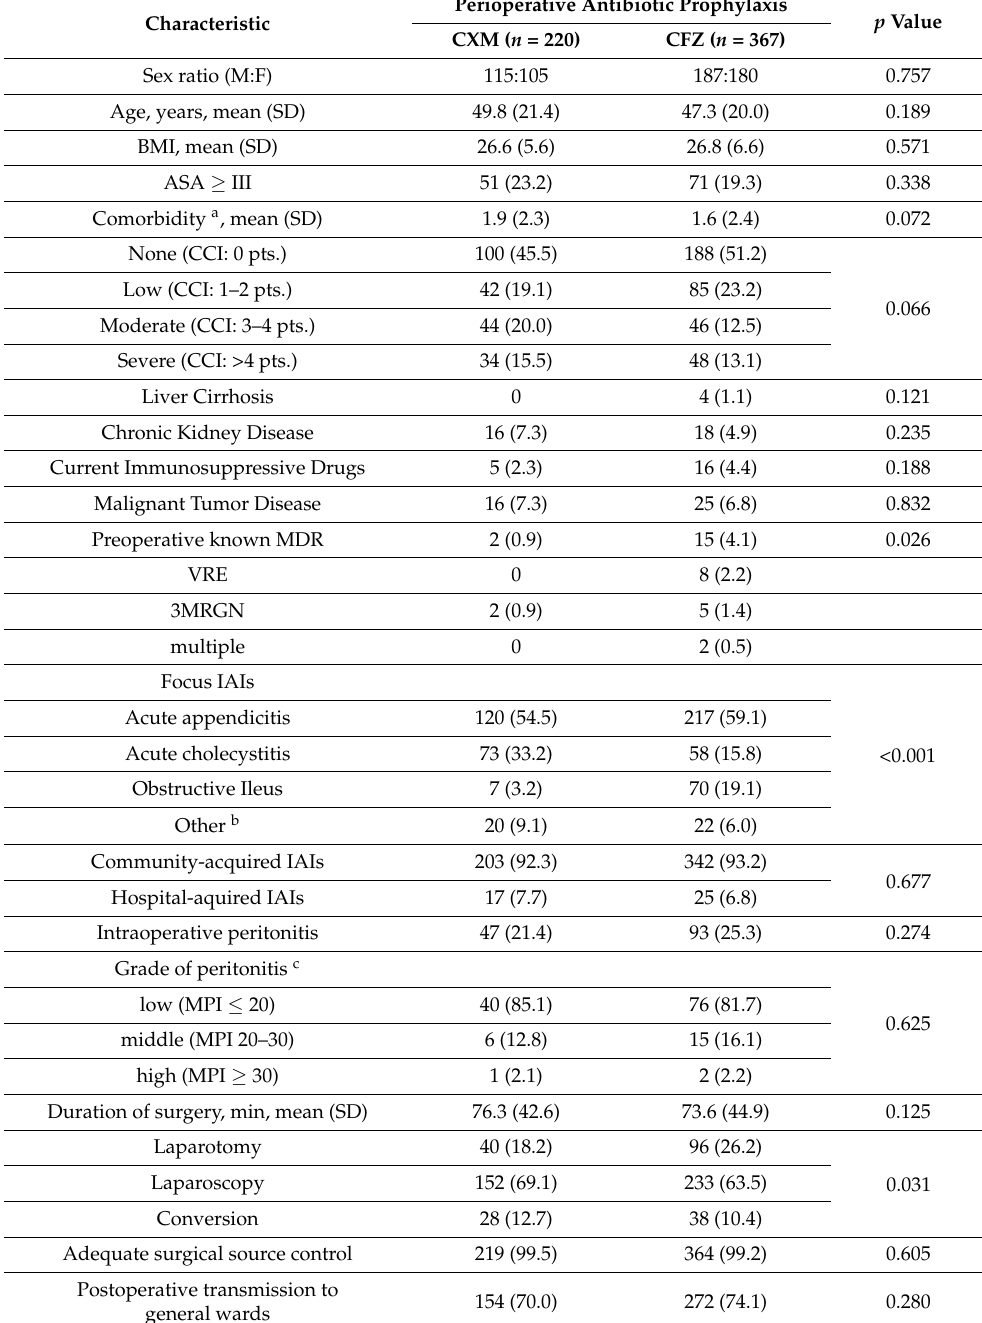
Table 2. Patient characteristics and intraoperative